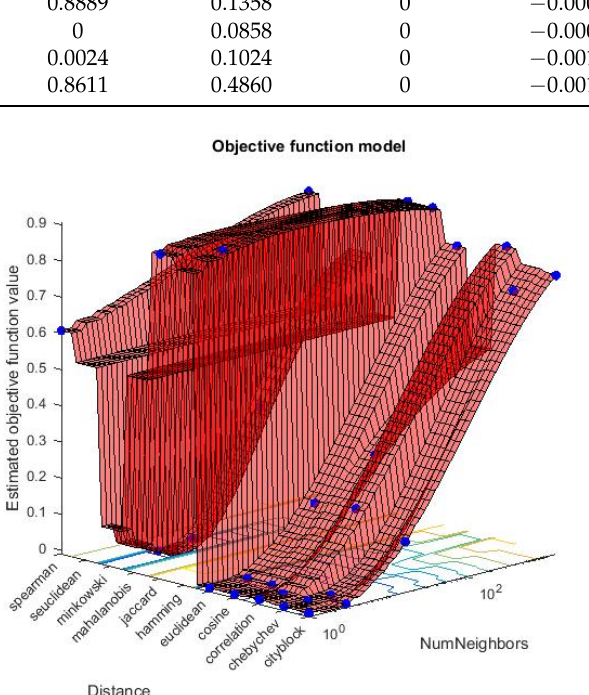
Figure A6. Objective function model for the k-NN classifier trained for the first mode of the second learning scheme (higher precision of localization).